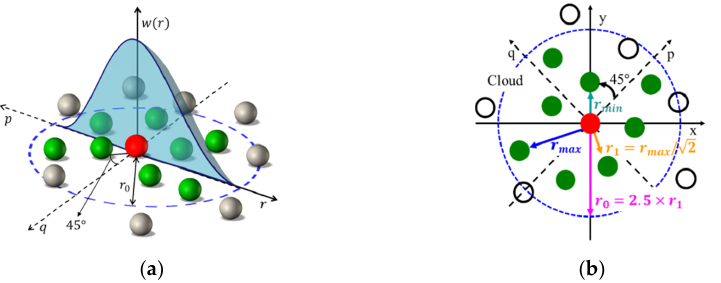
Figure 1. Schematic view of ( a ) a cloud with weighting function and ( b ) ways to construct the cloud.